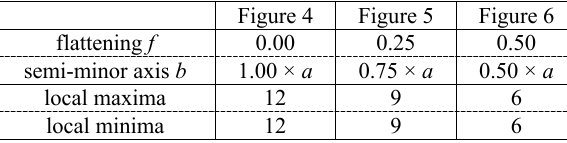
Table 1. Number of local maxima and local minima of the measurement accuracy by CM and EF (12 pixels  a  18 pixels,  = 0.0º) Figure 5 indicates that the measurement accuracy by SO would oscillate and have 18 local maxima and 18 local minima in the range {12 pixels  a  18 pixels}, while Figure 6 indicates that the measurement accuracy by SO has 6 local maxima and 6 local minima in the same range. The intervals between the adjacent local maxima in Figure 5 were not uniform similarly to the measurement accuracy of the center location of a circle by